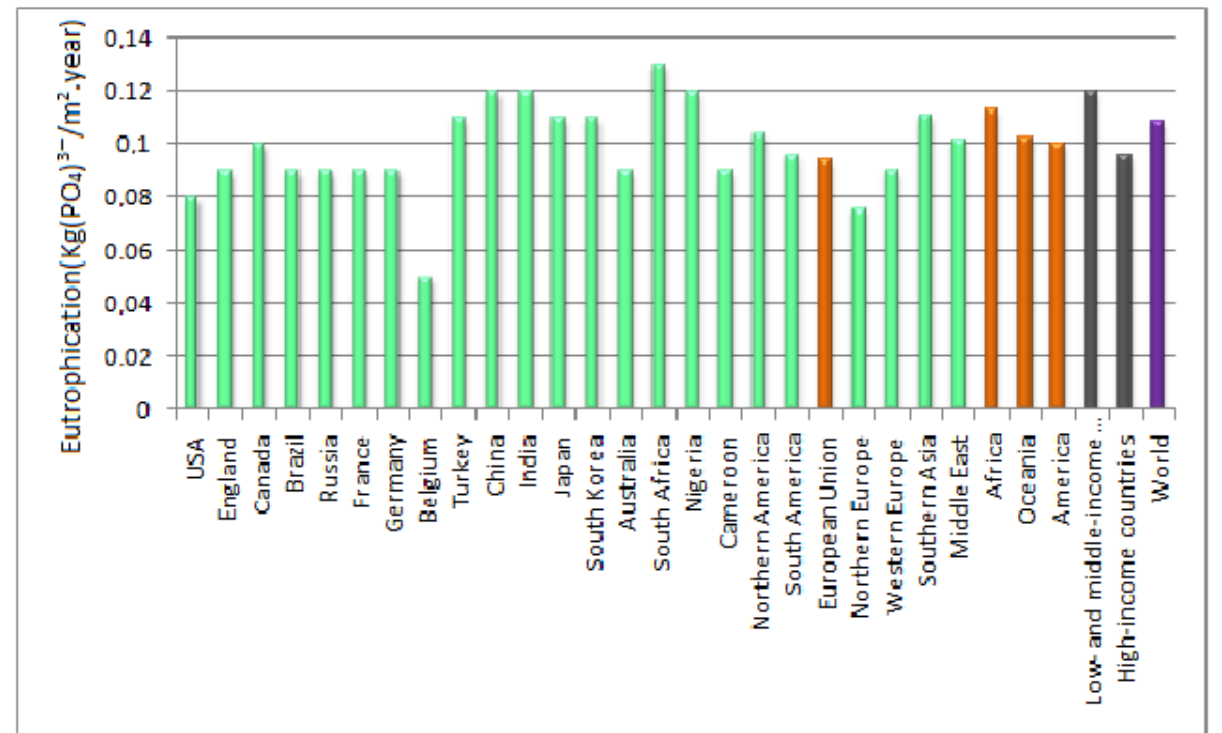
Figure 4. Assessment of eutrophication quantity per square meter coming from a sustainable neigh- borhood distributed in some countries, regions and continents in the world